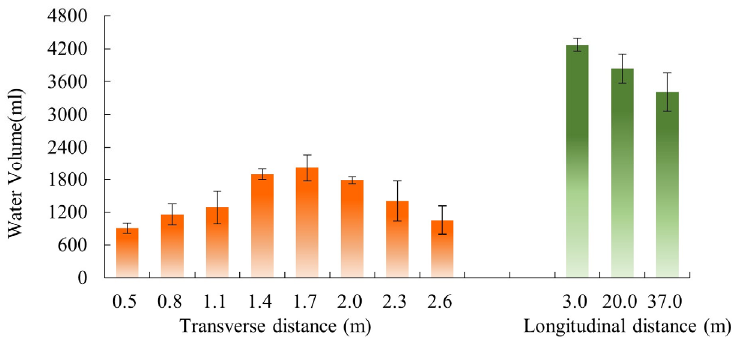
Figure 5. Water accumulation at the transverse sampling points and the longitudinal sampling points.